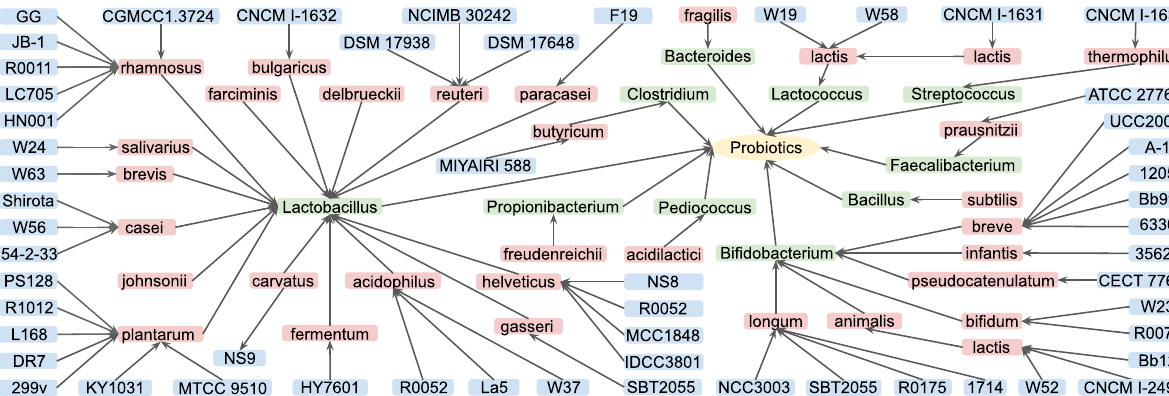
Figure 6. Hierarchy of probiotic strains in ppstatement knowledge base. Arrow lines indicate relations of ‘rdfs:subClassOf’. Green, red and blue rectangles represent the probiotic genera, species and strains, respectively.